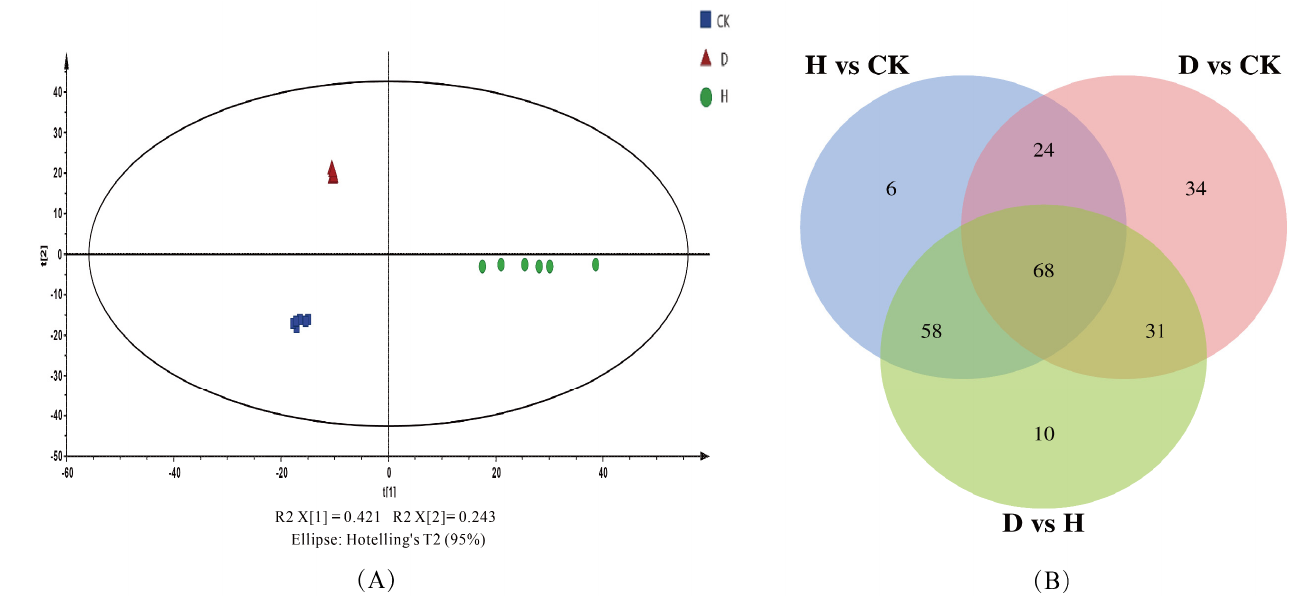
Figure 4. Principal component analysis (PCA, ( A )) and Venn diagrams ( B ) of metabolic profiles in Faba bean leaves treated with antifungal peptide P852, H: P852 at 10 μ g/mL, and D: 1 μ g/mL of P852 and CK, with sterile water to treat Fusarium wilt of Faba bean, Venn diagrams with overlapping different color sections represent the same metabolites from different treatments.